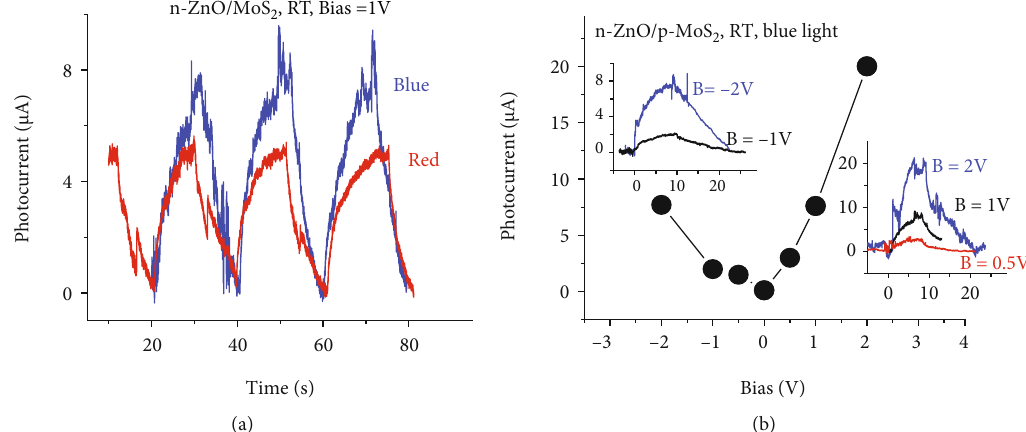
Figure 5: (a) E ff ect of bias on the responses of the n -ZnO NW/ p -MoS illuminations, respectively. (b) The generated photocurrent as a function of applied